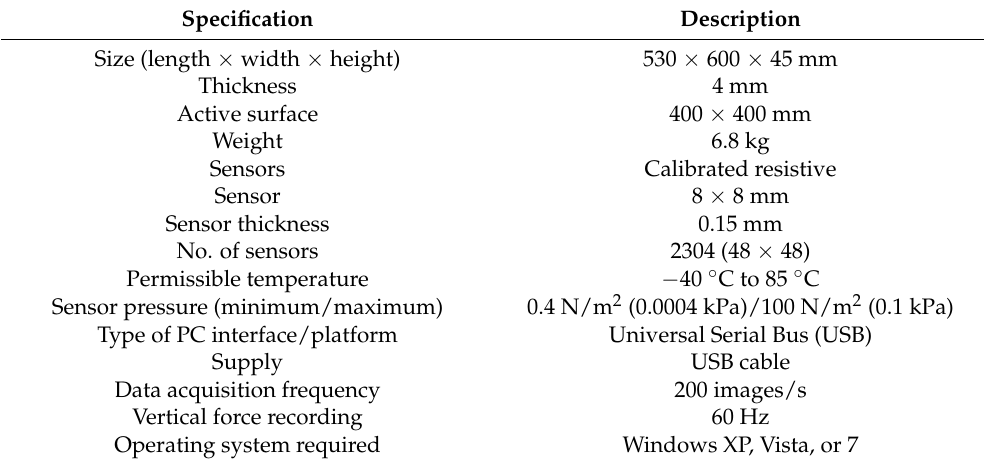
Table 2. Technical specifications of the pressure